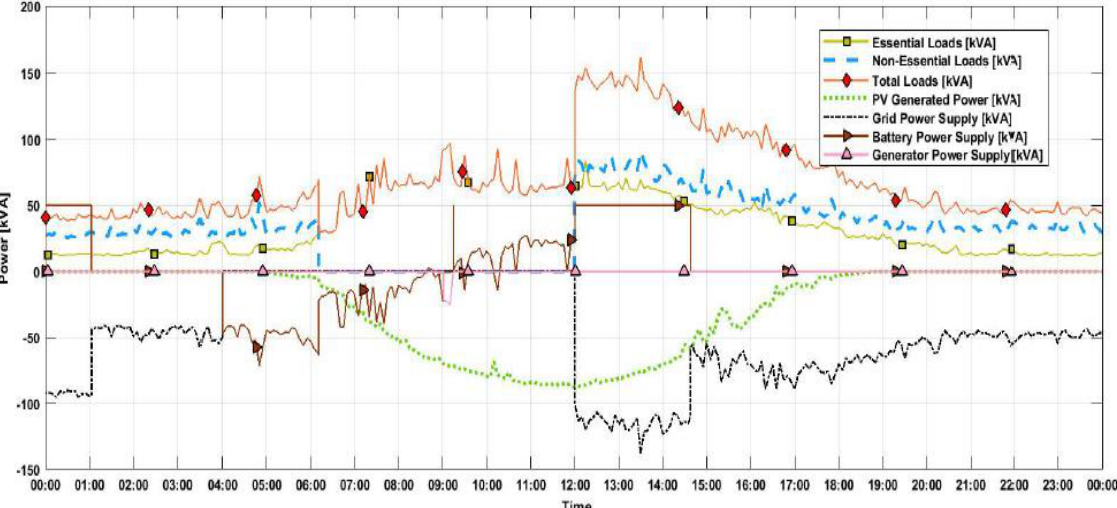
Figure 14. The behavior of MCAST micro-grid integrated with a 250 kWh BESS and 150 kVA diesel generator during an 8-h power cut.